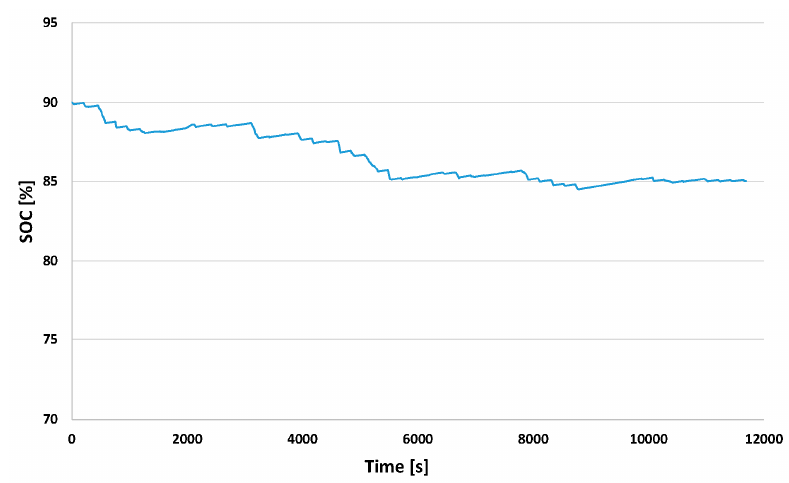
Figure 19. State of charge consumption during the cycle in FCEREV mode. Table 7. Comparison of FCEREV vs EV.